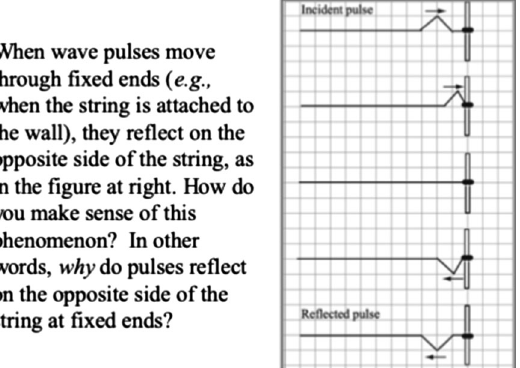
FIG. 8. The explain-style question for reflection (the why reflection question).